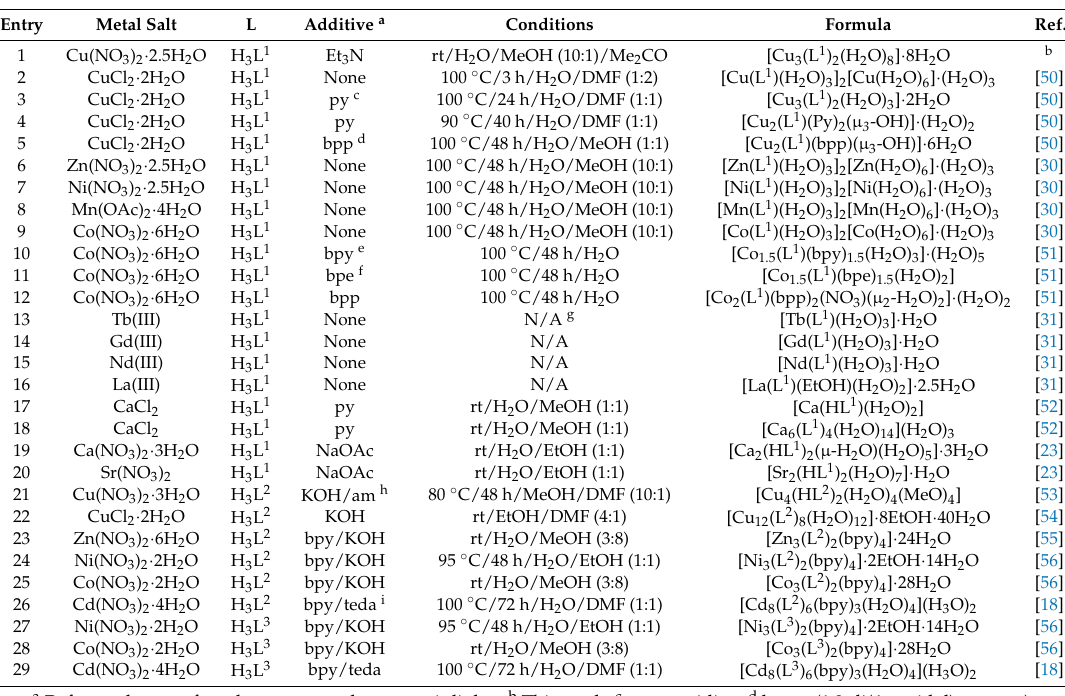
Table 2. Overview of the synthetic parameters and topology of all reported compounds with tripodal pseudopeptidic